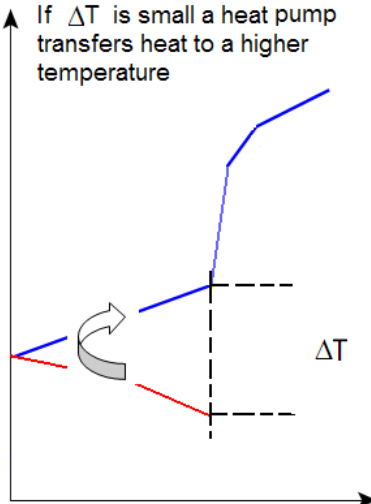
Figure 6. Use of a heat pump to exploit heat available below the